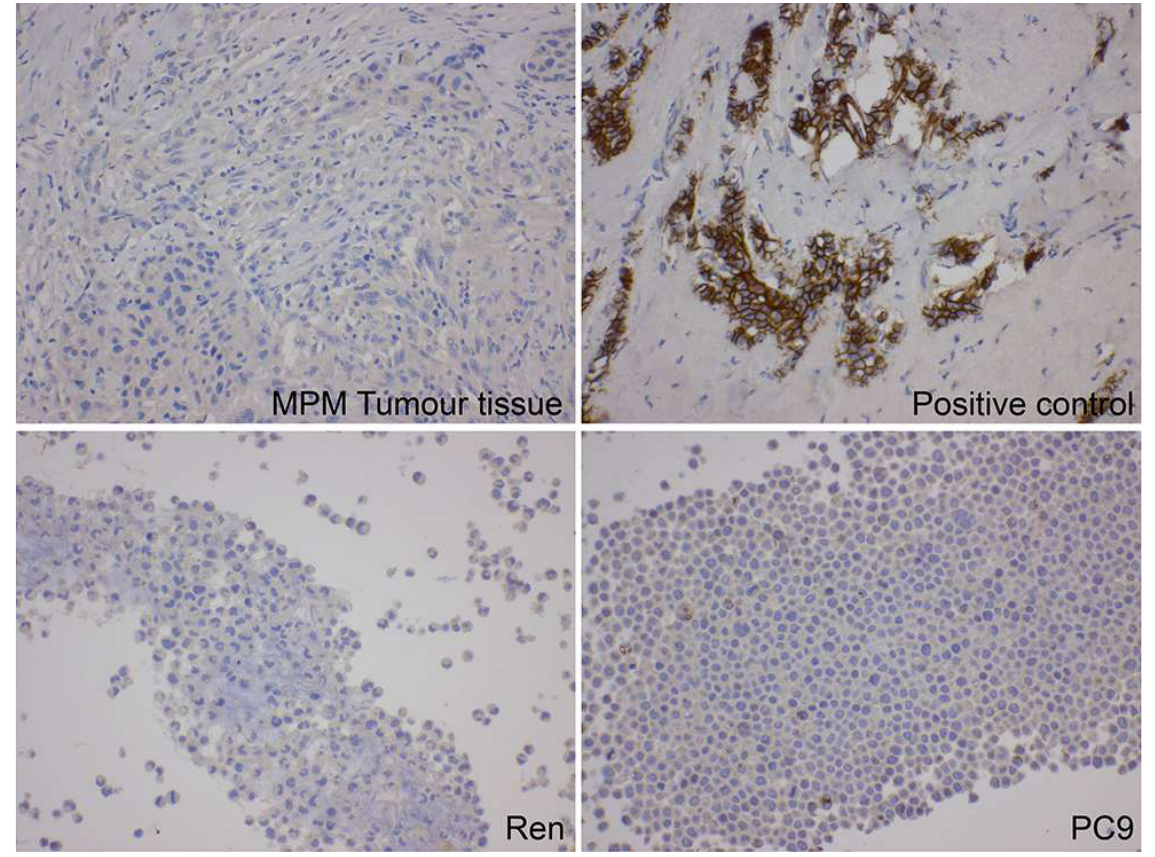
Figure 1. Protein expression as measured by IHC of E-cadherin for representative samples of the FFPE MPM tumour (top left), MPM cell line Ren (bottom left), lung cancer cell line PC9 (bottom right), and positive control breast tissue sample (top right). Images were captured with a ZEISS Axio.M2 microscope with 20× objective. Most MPM tumour and cell lines exhibited E-cadherin protein silencing. Table 1. E-cadherin IHC average results for 81 MPM FFPE clinical samples.